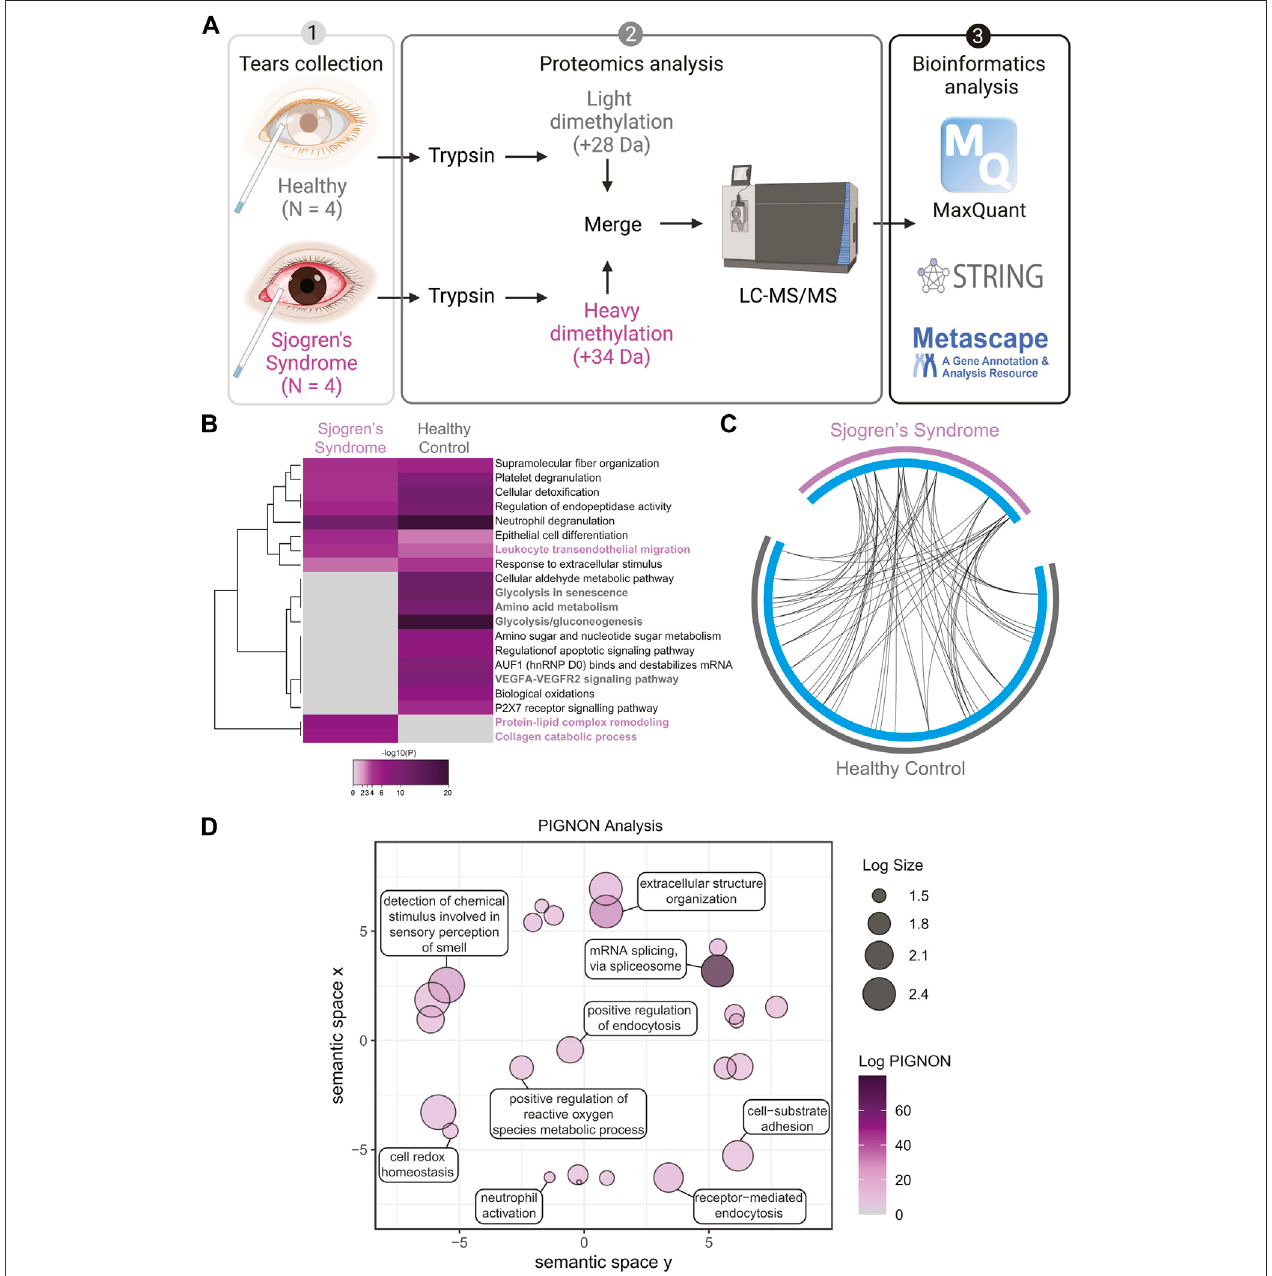
FIGURE1| QuantitativeProteomicsofHumanSjogren ’ sSyndromeTearsWashes. (A) Proteomicswork fl owandanalysis(N (cid:2) 4,Sjogren ’ ssyndrome(SS)andN (cid:2) 4 healthy controls). STRINGdb and Metascape software were used to identify pathway enrichment and protein-protein interactions. A list of all detected proteins is provided in Supplementary Table S1 . (B) Metascape analysisofdifferentpathwaysbetweenSS and healthy control tearwashes. Magenta marked are upregulated in SS and grey marked are upregulated pathways in healthy controls. Accumulative hypergeometric p -values and enrichment factors were calculated and used for fi ltering. Remaining signi fi cant terms were then hierarchically clustered into a tree based on Kappa-statistical similarities among their genes memberships. Then, 0.3 kappa score was applied as the threshold to cast the tree into term clusters. (C) Circos plot shows how signi fi cant proteins from the input lists overlap and were generatedwithMetascape. Ontheoutside,eacharcrepresentstheidentityofeachgenelist(Sjogren ’ ssyndromeinmagentaandHealthy controlingrey).Ontheinside, each cyan arc represents a gene list, where each gene has a spot on the arc. Black lines link the different genes where they fall into the same ontology term. (D) Visualization of PIGNON results using Revigo. The x- and y -axis have no intrinsic meaning. In the plot, semantically similar GO terms remain close together. LogSize equals to the Log 10 (Number or annotations for GO Term ID in Homo sapiens in the EBI GOA database). Log PIGNON equals to the -Log 10 (FDR-adjusted p value as